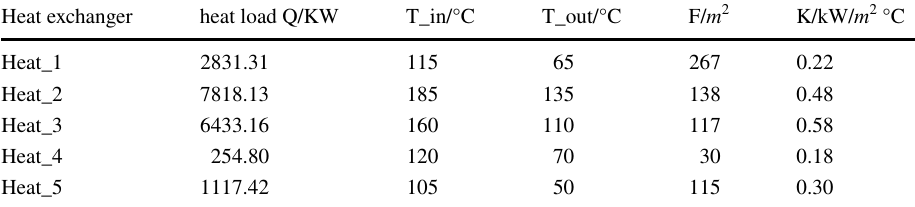
Table 2 Known parameters of process heat exchange